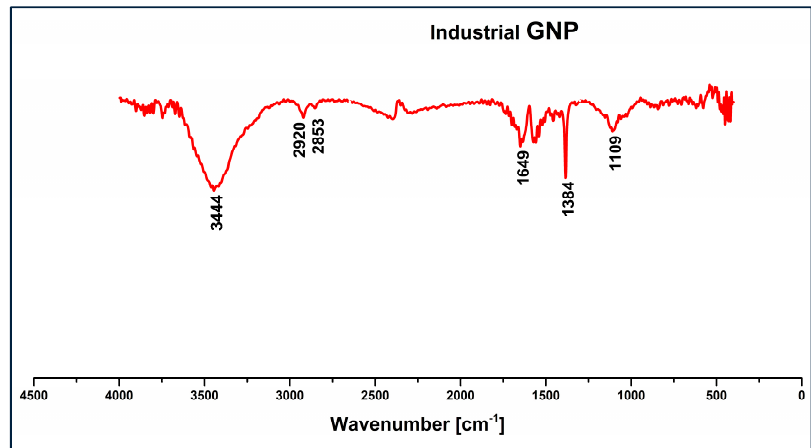
Figure 1. IR spectrum of GNPs.